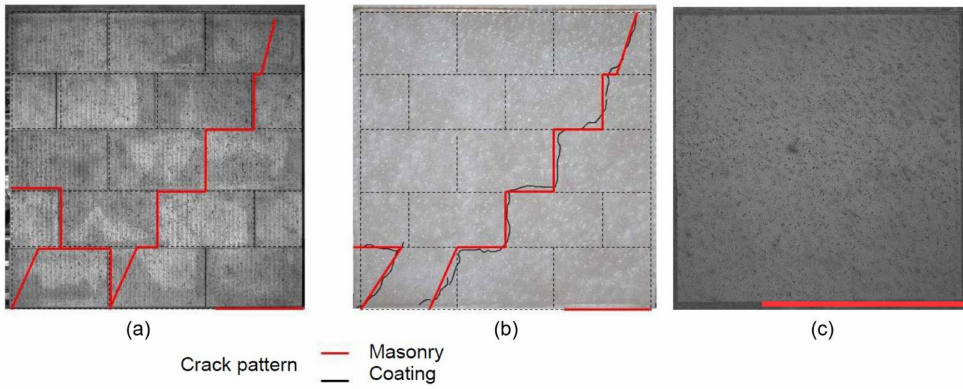
Figure 4. Crack patterns on the wall surfaces at masonry failure for specimens: ( a ) URM B1, ( b ) ISO-coated B7, and ( c ) MGF-coated